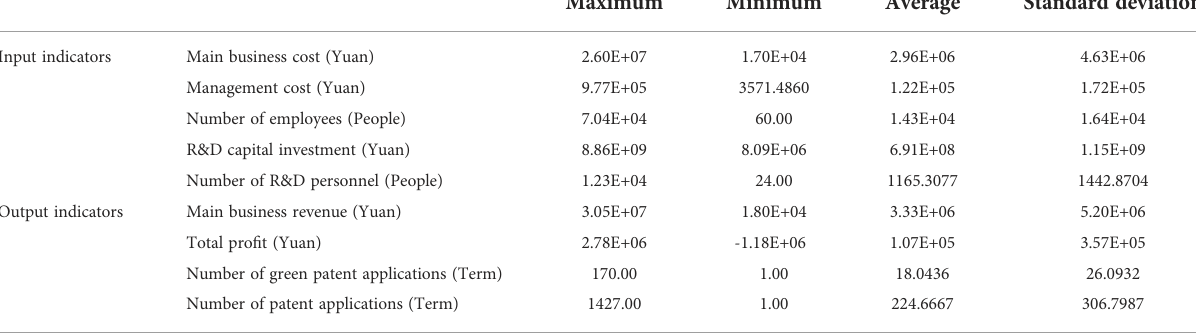
TABLE 1 Descriptive statistics of input and output